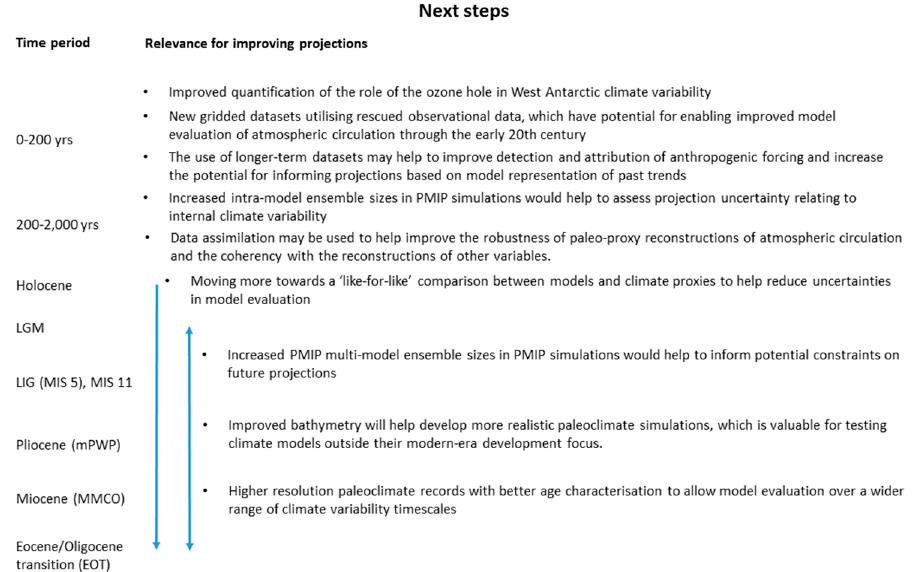
Figure 4. As Figure 2 but from the sections on ‘next steps’.